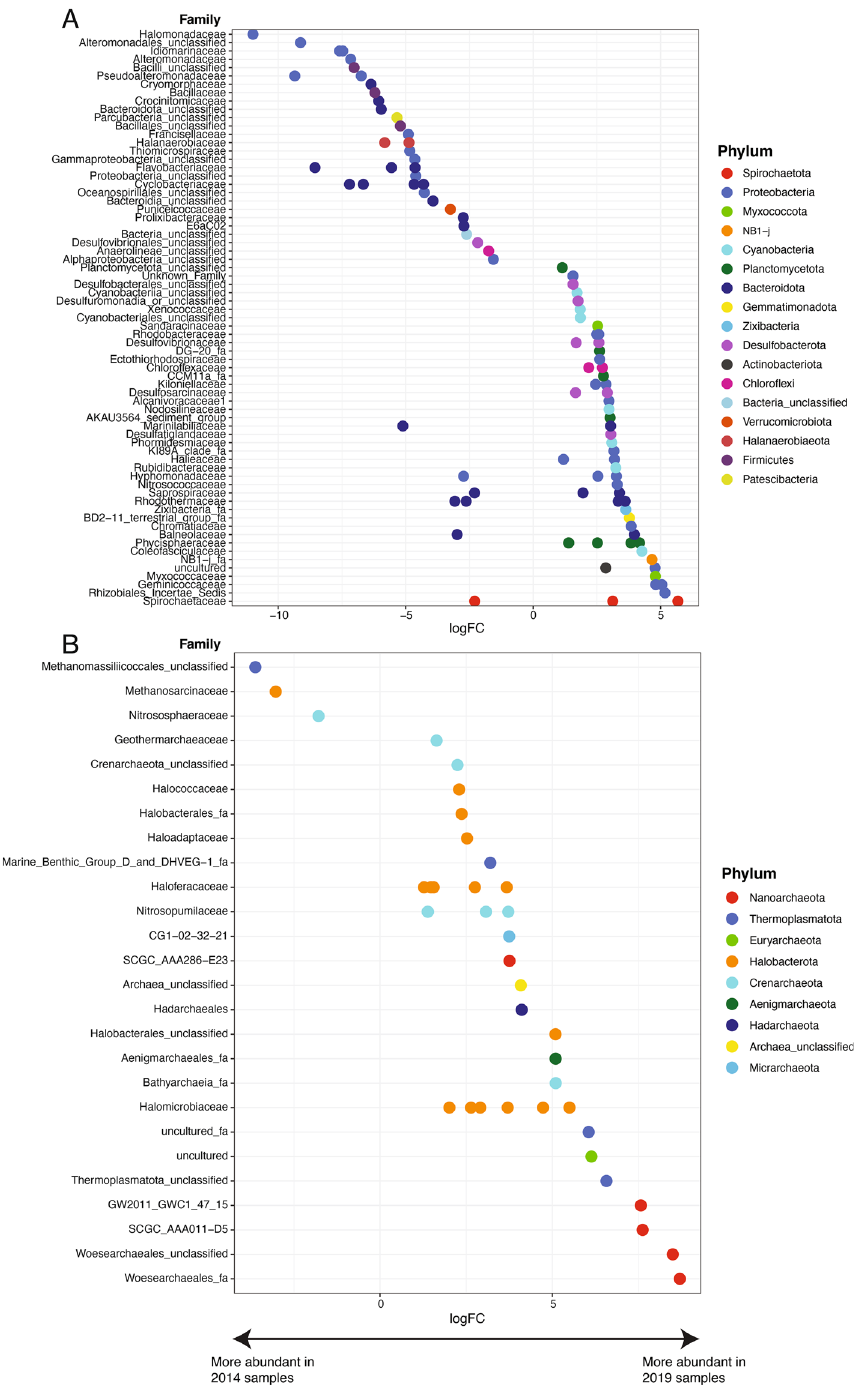
Figure 4. LogFC pairwise comparison between ( A ) bacterial and ( B ) archaeal families within 2014 and 2019 samples with significant differences (p < 0.05). Positive logFC values on the x-axis indicate families that are more abundant in 2019 lake sediment samples, and negative logFC values on the x-axis indicate families that are more abundant in 2014 lake sediment samples. Colors of circles denote the phyla for each listed family, shown in the legend. All analyses were performed using R Statistical Software (v4.1.3; R Core Team 2022, https:// www.R- proje ct.